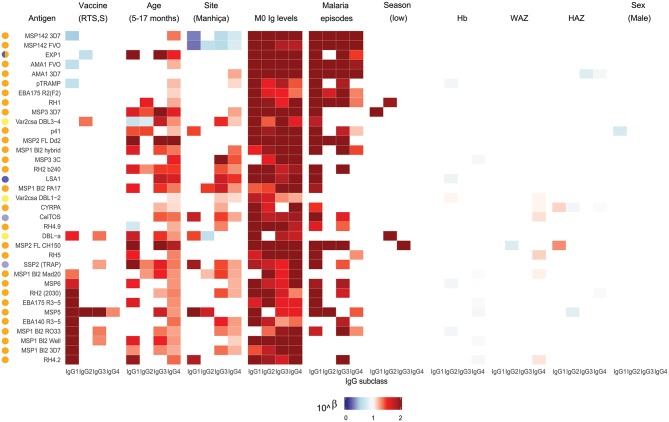
Heatmap of multivariable analysis of the effect of RTS,S/AS01E vaccination and demographic, clinical, and epidemiological variables on IgG subclass levels to Plasmodium falciparum pre-erythrocytic and blood stage antigens at month 3 visit. Linear regression was performed with antibody levels (log10MFI) as outcome and other covariates adjusted (in parenthesis the reference category). Color coded cells show the 10∧Beta of each predictor (columns) for each model (rows). Only results with a significant (<0.05) p-value are shown. Antigen colors show the P. falciparum life cycle stage in which they are expressed: Pre-erythrocytic (PE) antigens from sporozoite stage (light purple), PE from liver stage (dark purple), blood stage (BS) antigens from merozoite stage (orange), BS from trophozoite stage (yellow).